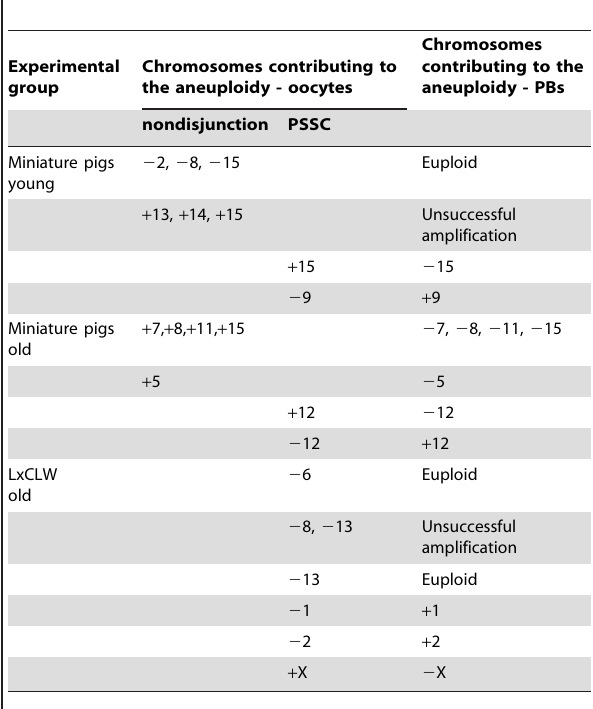
Oocytes with incorrect number of chromosomes are shown for each group. The origin of aneuploidy (chromosome non-disjunction versus premature segregation of sister chromatids - PSSC), chromosomes contributing to aneuploidy and the result of analysis of the corresponding polar body are shown for each cell. LxCLW stands for crossbred of Landrace and Czech Large White